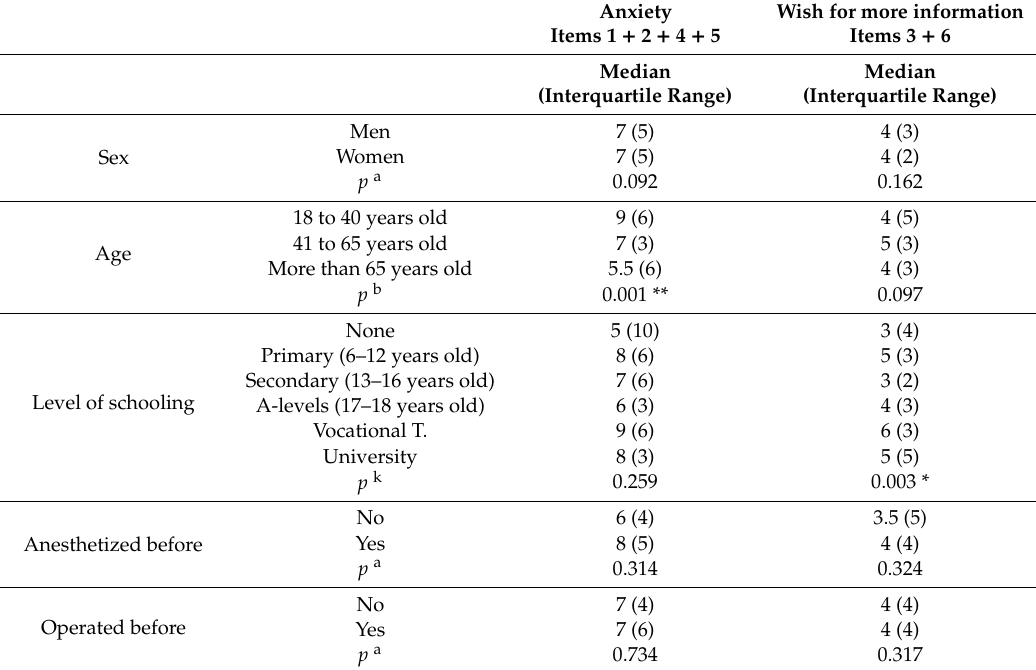
Table 4. Results of the analysis between the variables and the subscales of the